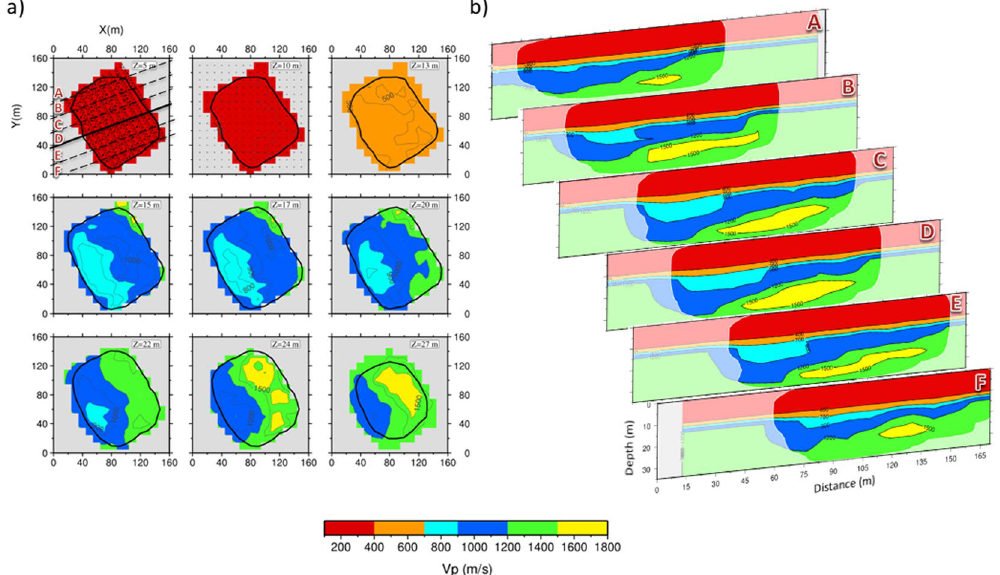
Figure 3. P-wave velocity model. ( a ) Horizontal slice of P-wave velocity model at different depths. The black contour delimitates the resolved area, i.e. the area for which the tree resolution parameters (RDE, Sj and DWS ) are included in a threshold value. The threshold values of S j and DWS are chosen in order to obtain a similar contour, binding the RDE to be higher than 0.9. The grey regions in each slice represent areas not covered